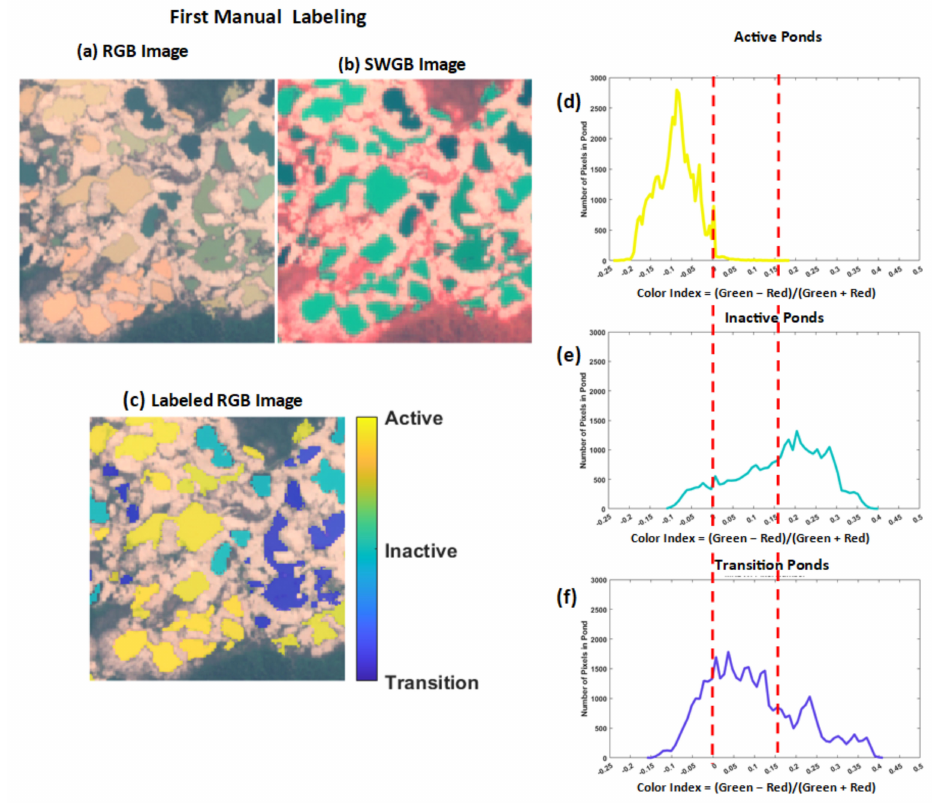
Figure 3. We manually labeled the state of each pond using the Labelbox tool using RGB and SWGB composite images. The composite images ( a ) RBG and ( b ) SWGB display a multitude of ponds clearly, and label categories ( c ) affixed to these images. Using a color index [(green − red)/(red + green)], ponds can be differentiated with respect to the presence of sediment and photosynthetic material and describe ( d ) active, ( e ) inactive, and ( f ) transition